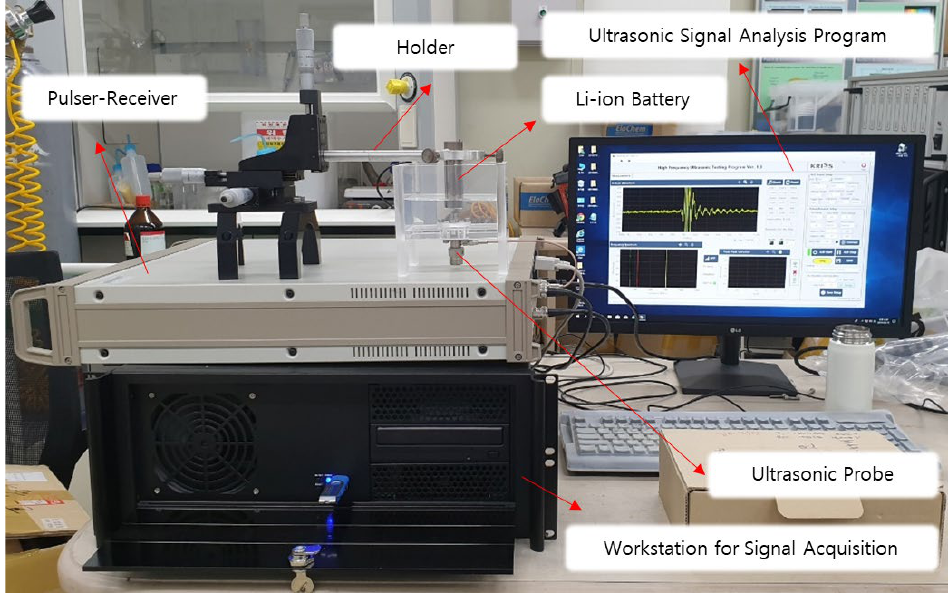
Figure 4. A photograph of the ultrasonic testing set-up for nondestructive evaluation of battery- electrode welds.